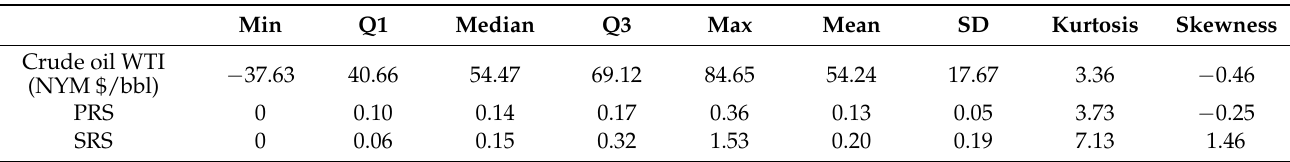
Table 1. Summary statistics of the crude oil WTI (NYM $/bbl) front month futures contract price and the pandemic risk scores.